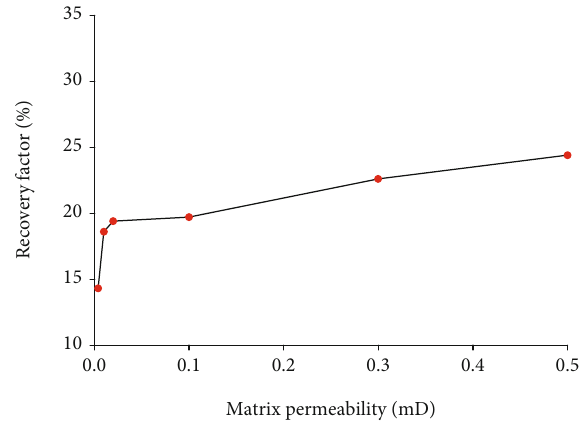
Figure 8: Ultimate recovery factors of reservoirs with di ff erent capillary pressure multipliers by cyclic surfactant